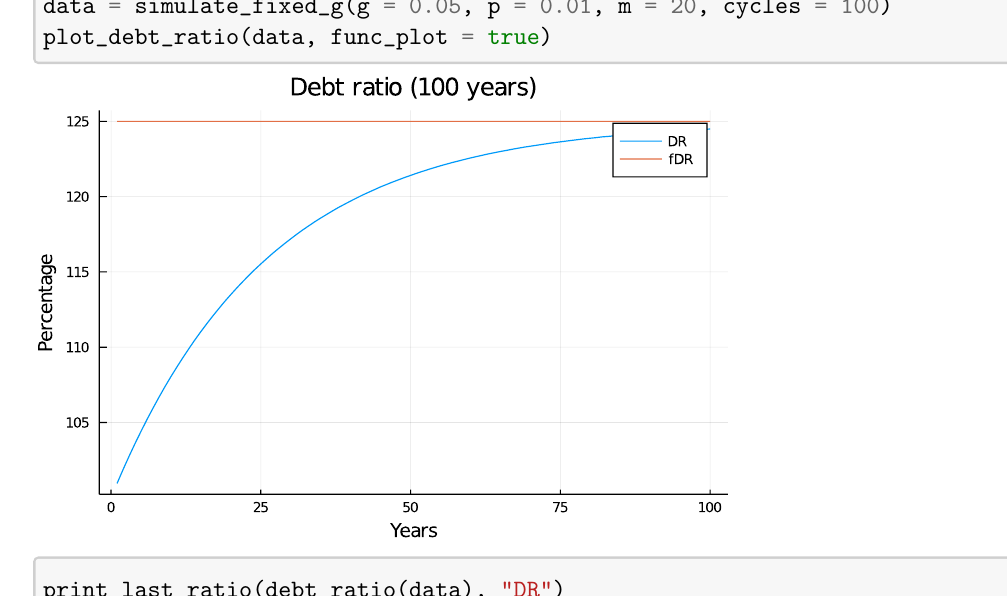
Figure 20. Debt ratio (g = 5%, p = 1%, m = 20